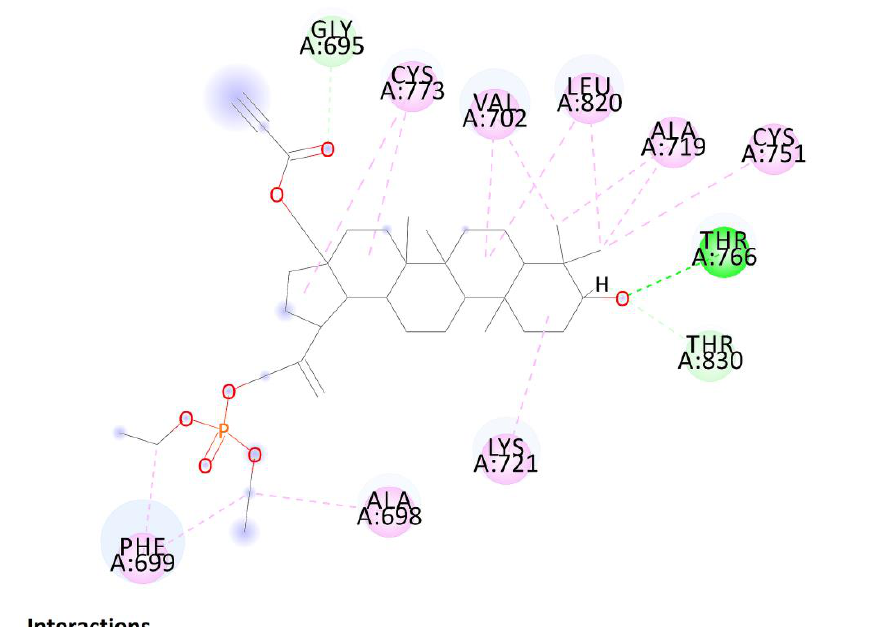
Figure 13. Two-dimensional (2D) binding interaction of 7a with EGFR. The pose of compound 7b in the binding site showed hydrophobic interactions with 21 amino acids residues including interactions with Asp831, Phe832, and Gly833 (DFG motif). According to the obtained literature data, interactions with DFG motif play a sig- nificant role in tyrosine kinase activity [53]. Moreover, hydroxy groups of triterpene in positions C3 were involved in hydrogen bonds to carboxyl oxygen atom of Thr766, stabi- lizing the obtained complex (Figure 14).